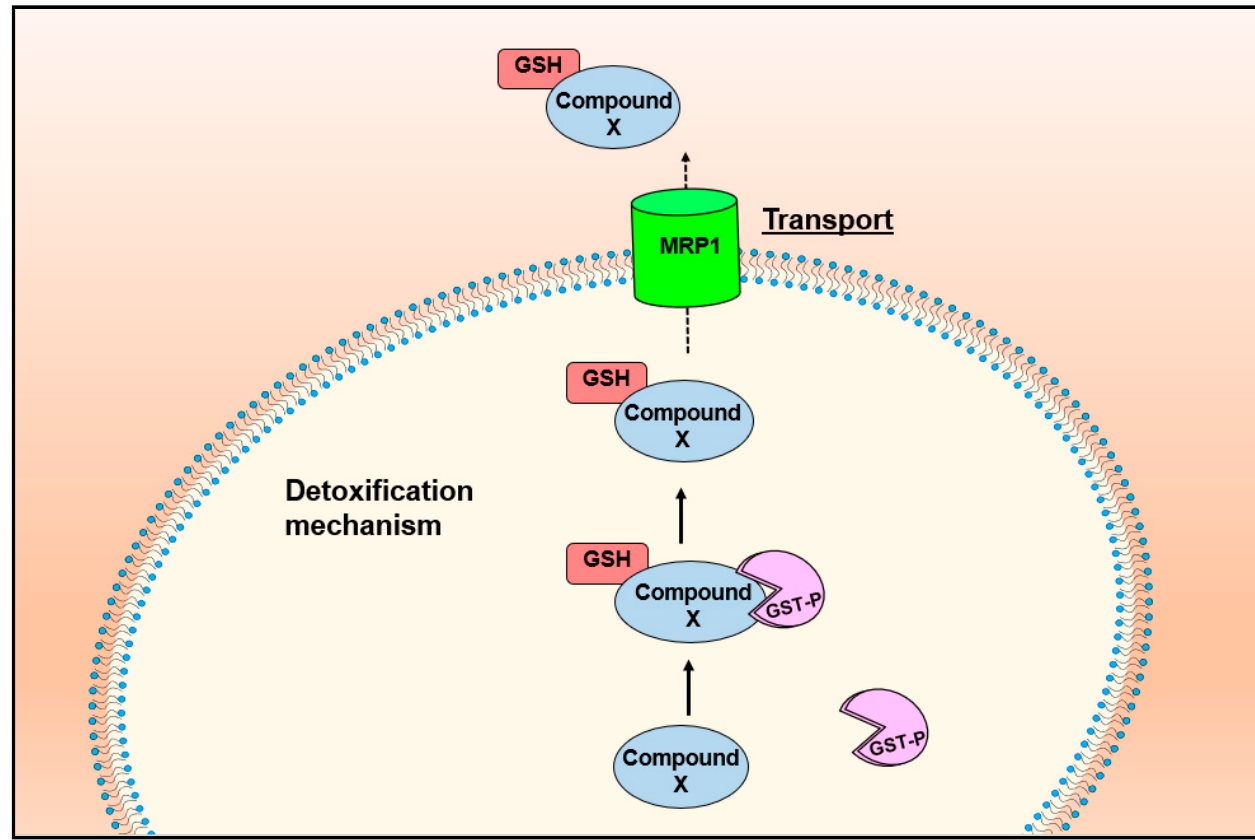
Figure 8. Detoxification mechanism between MRP1 and GST enzymes. GST enzymes conjugate GSH to toxic compounds to target them for export out of the cell by the GSH-conjugate transporter, MRP1.